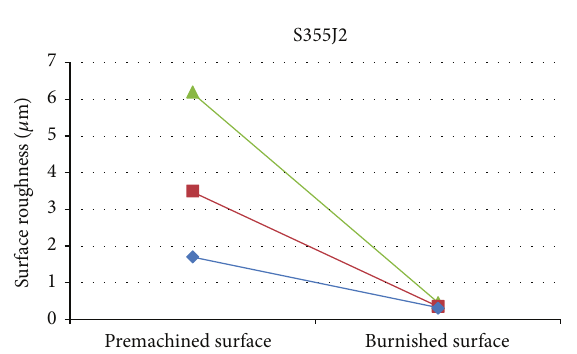
Figure 5: This shows how the burnishing process affected the surface roughness values of the S355J2